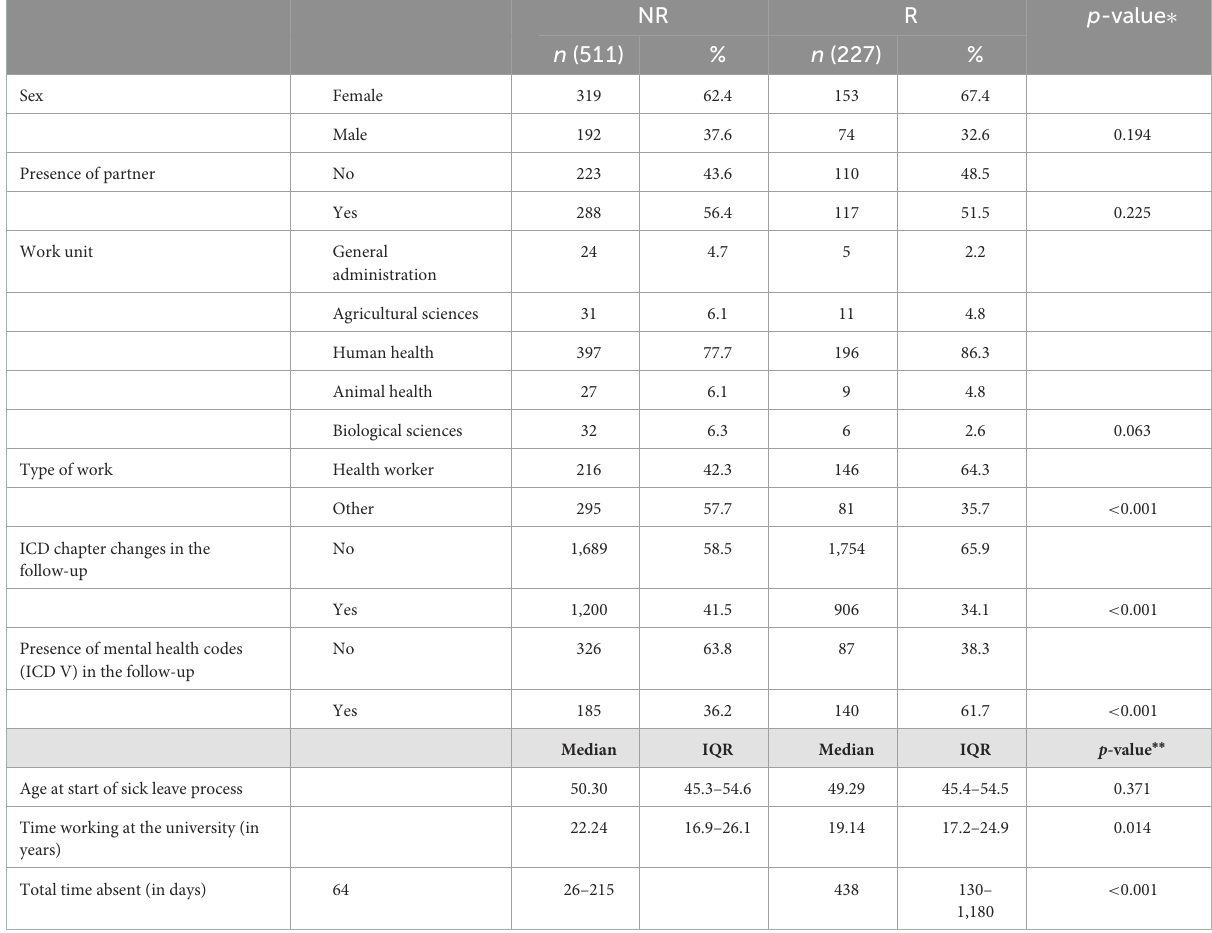
TABLE 1 Exploratory data analysis between the group of workers who returned to work without readaptation (NR) and those who returned after passing through readaptation